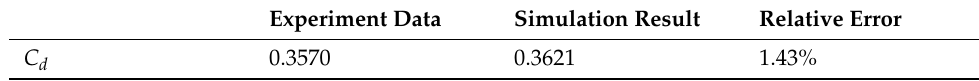
Table 3. Comparison of the CFD simulation result and the experiment